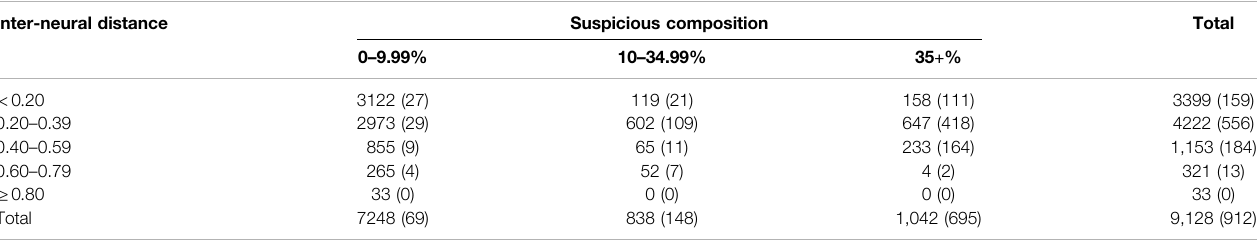
TABLE 3 | The distribution of the fi fth-fold cross-validation training accounts along the risk categorisation matrix. Notation of the numbers is: all accounts (suspicious accounts).